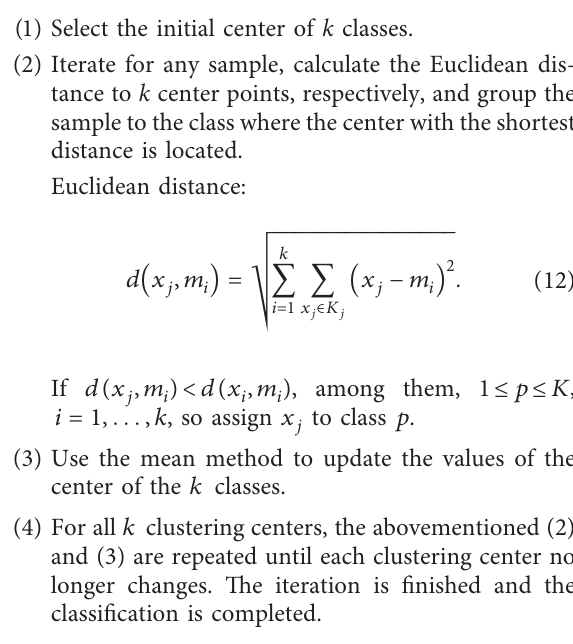
Figure 13: Schematic diagram of data points on the surface of hematoma.